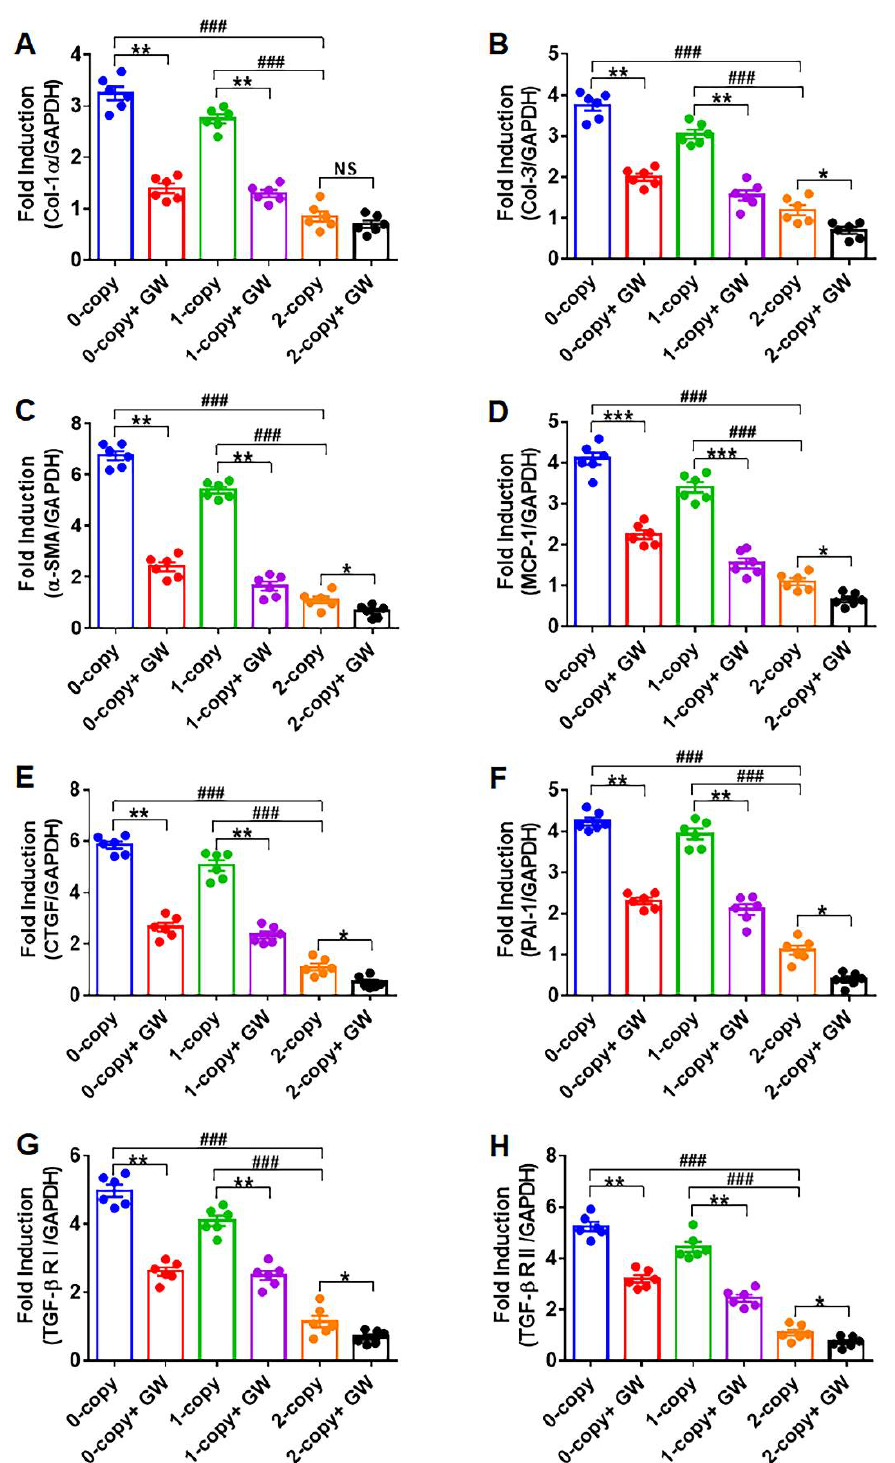
Figure 1. The expression analysis of the mRNA of fibrotic marker genes in the heart tissues of control and GW788388 drug-treated male Npr1 gene-disrupted mice: The expression levels of mRNA of Col-1- α , Col-3, α -SMA, MCP-1, CTGF, PAI-1, TGF- β 1RI, and TGF- β 1RII in the heart tissues of control and drug-treated mice are shown in panels ( A – H ). The expression of mRNA was normalized to GAPDH expression. Values are expressed as means ± S.E. (n = 6 animals in each group). Statistical significance is expressed as ### p < 0.001, vehicle-treated 0-copy and 1-copy vs. 2-copy; * p < 0.05, ** p < 0.01, *** p < 0.001, vehicle-treated 0-copy, 1-copy and 2 copy vs. drug-treated same gene copy number. NS: not significant.